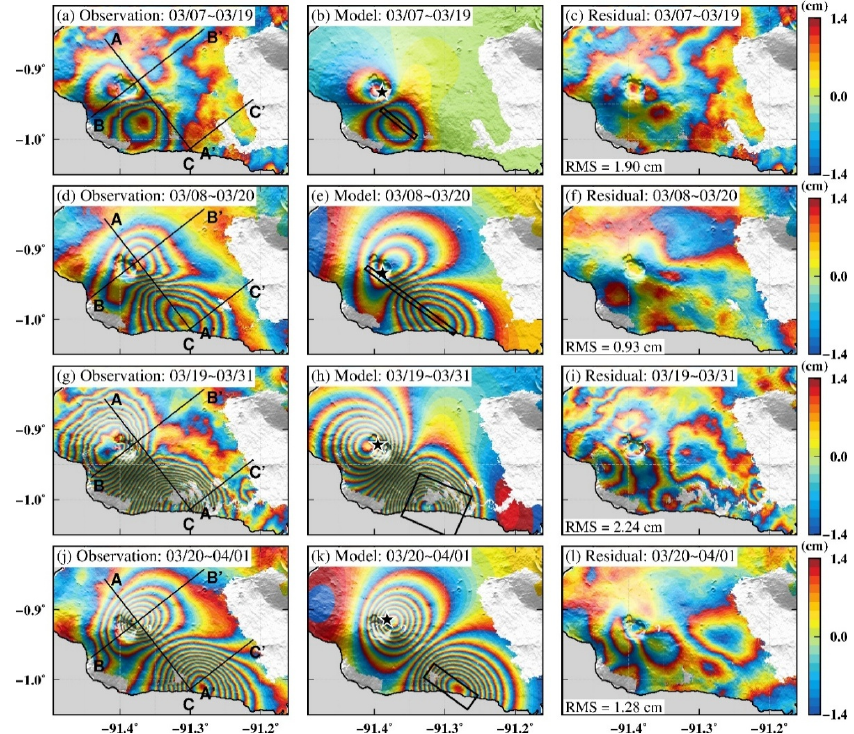
Figure 3. Deformation observed by the Sentinel-1A satellite and simulated by the joint deformation source model in interferograms III–VI. Each fringe represents the displacement of 2.8 cm in the LOS direction. The locations of the Mogi and Sill models projected onto the surface are drawn with black pentacles and rectangles, respectively. Three profiles, A-A’, B-B’ and C-C’, through the positive and negative displacement regions are shown in Figure 4.